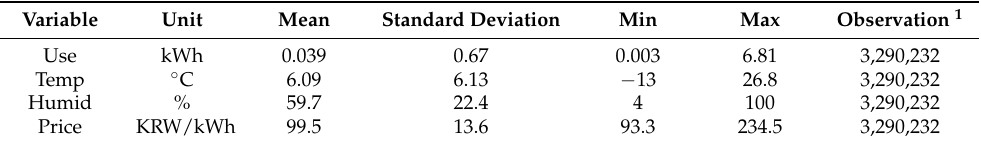
Table 2. Summary of time variant variable statistics.